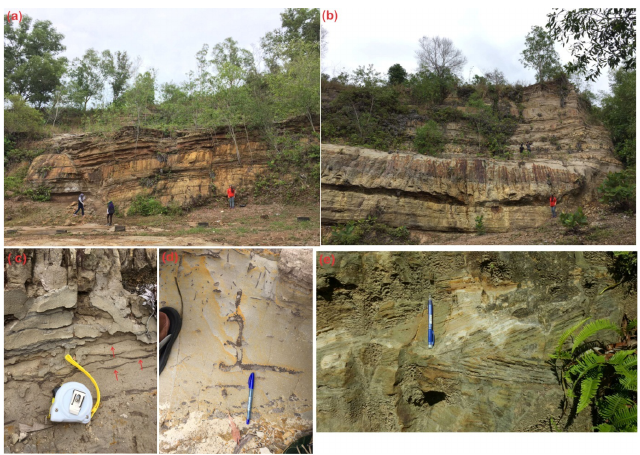
Figure 3: (a) (b) (c) and the Miri Formation outcrops along the Airport road. The flaser lamination structure display by red arrow. Ophiomorpha sp. showing in an individual bed of outcrop. herringbone cross stratification display on bed. 4.4 Facies 2: swaley cross stratified (ScS)